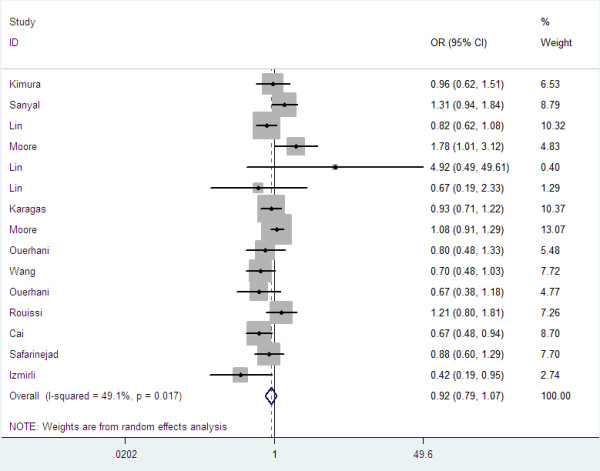
Forest plots for MTHFR Ala222Val polymorphism and risk of bladder cancer in overall populations (Recessive model).